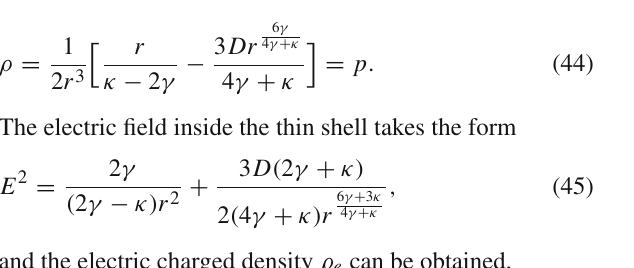
The expressions for matter density and isotropic